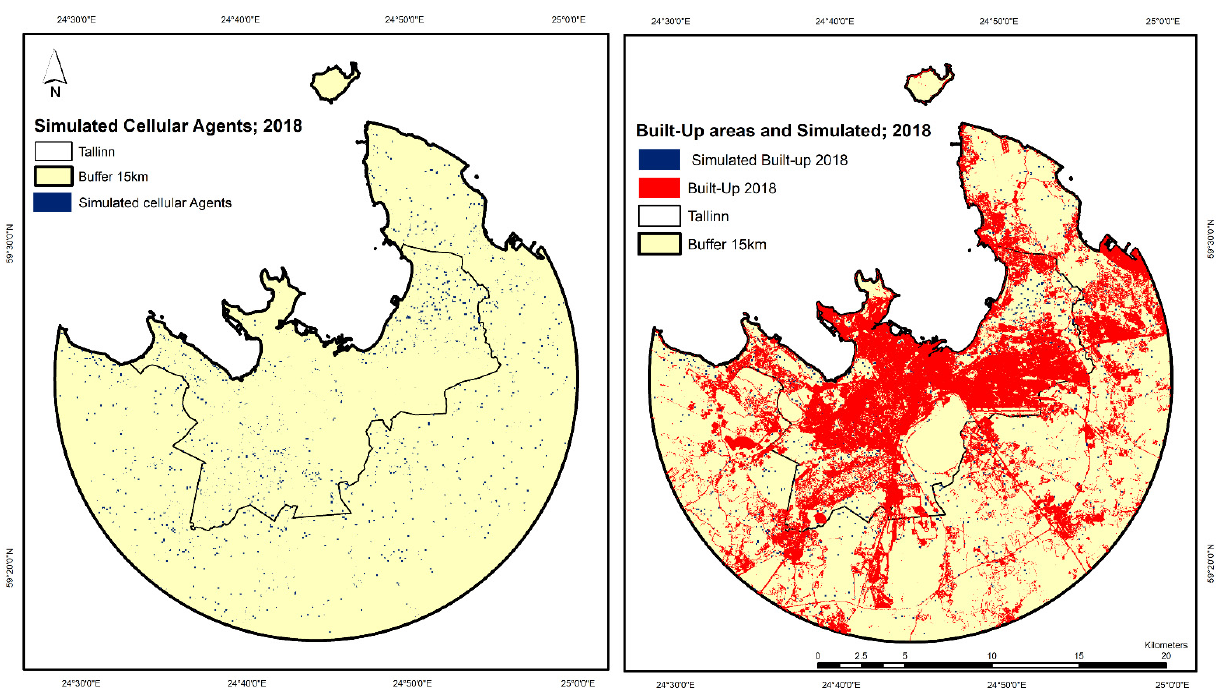
Figure 6. Simulated map of urban expansion in 2018. Figure 6 . Simulated map of urban expansion in 2018.